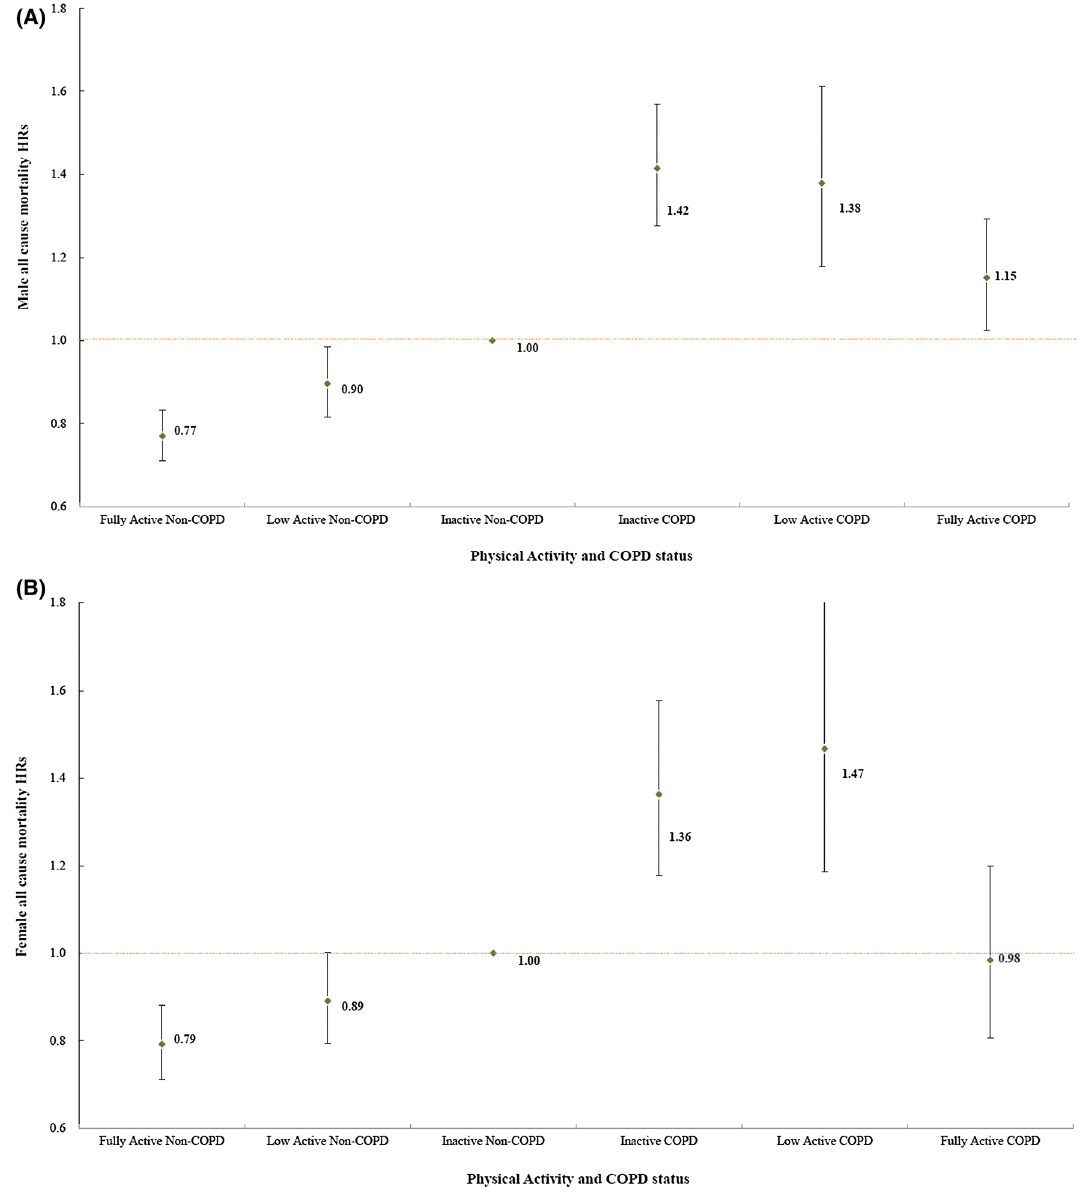
Figure 1. Male ( A ) and Female ( B ) hazard ratios (HR) for all-cause mortality risk by chronic obstructive pulmonary disease (COPD) and Leisure time exercise status. HRs were adjusted for age, gender, education, body mass index, smoking habit, anemia status, hypertension, and fasting blood